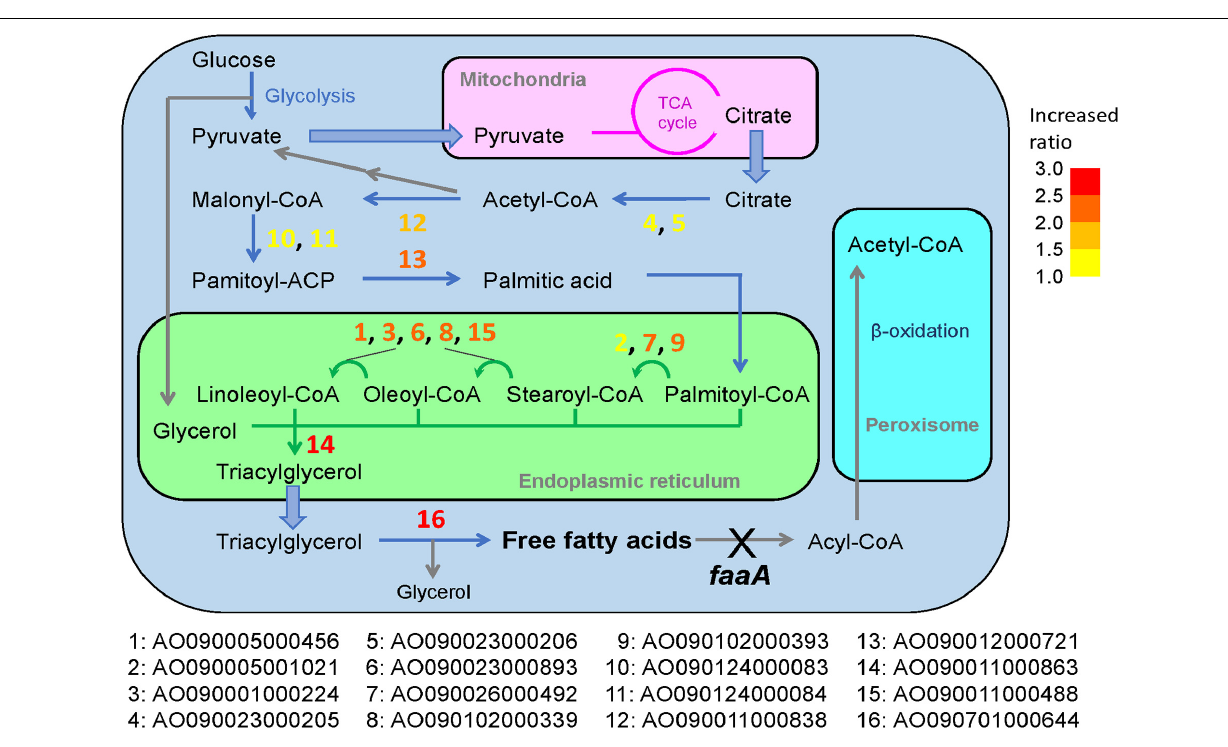
FIGURE 4 | Predicted reactions of the overexpressed genes in the general metabolic pathway for FFA production in the (cid:49) faaA strain. The 16 genes that were subjected to overexpression modification in addition to faaA disruption were designated with numbers from 1 to 16. These numbers are overlaid on the metabolic pathway map and marked by a corresponding color to indicate the FFA secretory productivity change as a ratio compared to the (cid:49) faaA strain. Increasing FFA secretory productivity is shown by the color of the gene number, shifting from yellow to red. The degree is based on the color key in the top right of the